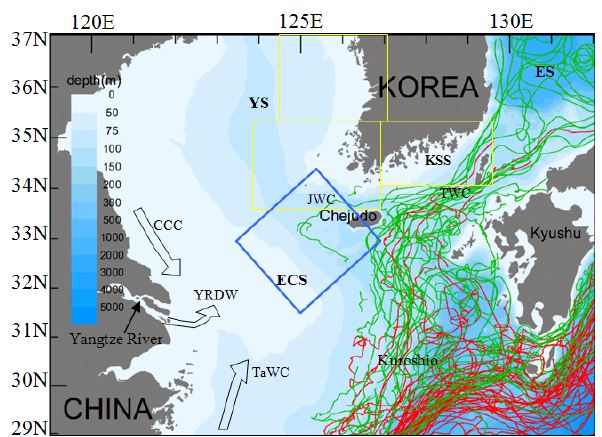
Fig. 1. A map showing the study area and sampling grids from where in-situ bio-optical data were collected during the R/V EARDO, Olympic and Tamgu cruises (1998-2005) in the Korean South Sea (KSS, R/V Olympic), Yellow Sea (YS, R/V EARDO and Tamgu) and East China Sea (ECS, R/V EARDO). The yellow and blue colour boxes represent the in-situ measurements of CDOM and salinity along with other optical measurements respectively. YRDW – Yangtze River Diluted Water, CCC – China Coastal Current, TaWC – Taiwan Warm Current, JWC – Jeju Warm Current, TWC – Tsushima Warm Current, Kuroshio Current, ES – East Sea. The current patterns and bathymetry information came from Lie et al. (1998) and Shanmugam et